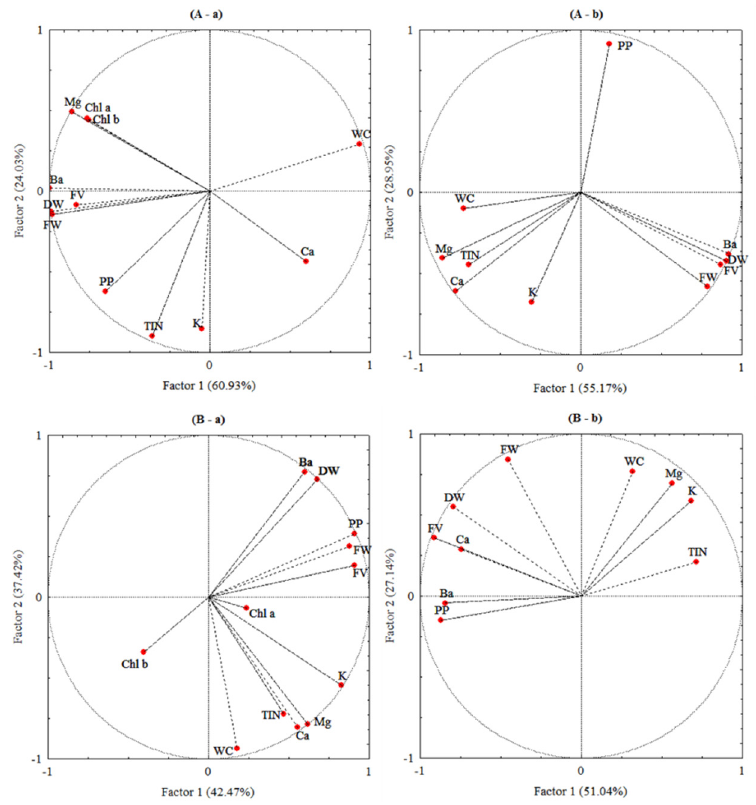
Figure 6. Correlation circle from the principal component analysis (PCA) of barium concentration (Ba), dry biomass (DW), fresh biomass (FW), water content (WC), chlorophylls (Chl a and Chl b ), polyphenols (PP), flavonoids (FV), and nutrient contents (potassium (K), calcium (Ca), magnesium (Mg), and total inorganic nitrogen (TIN)) data of the shoots ( a ) and roots ( b ) of Limbarda crithmoides ( A ) and Helianthus annuus ( B ).